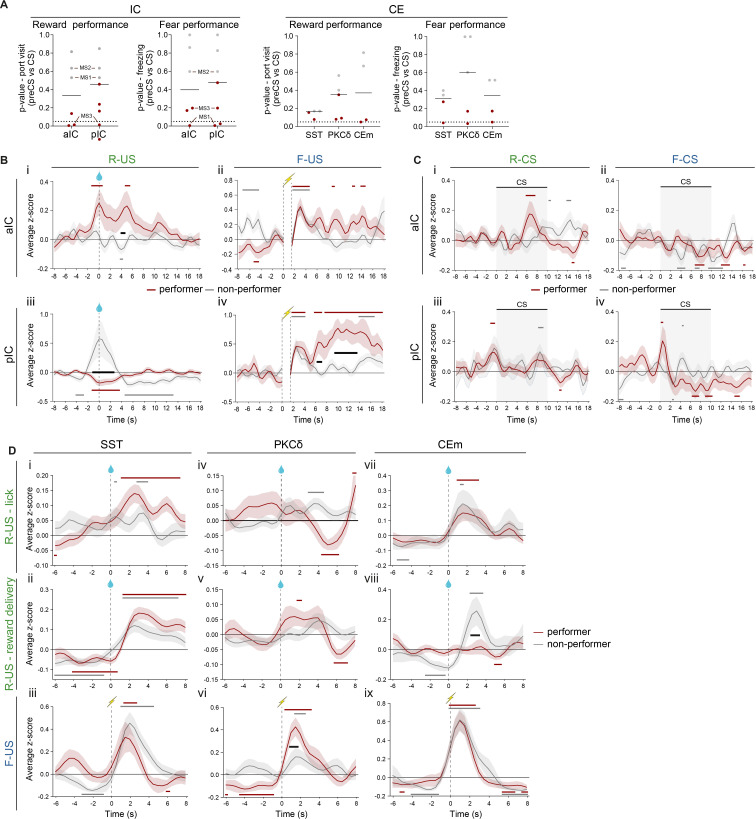
Performance-dependent responses to Pavlovian learning task stimuli in IC and CE.In all panels, black lines indicate significant differences (p<0.05) between subregions/populations, as determined by Holm-Sidak post hoc analyses, while colored lines indicate significant differences (p<0.05) from zero for each subregion/population, as determined by one-sample t-tests. All data presented as mean ± SEM. (A) Performance of individual mice in the reward (left) and fear (right) domain in IC and CE, as determined by the p-value from t-tests comparing the number of port visits (reward) and freezing episode onsets (fear) before and during CS presentations at recall. Color assignment of individual points according to a median split of p-values (red – performer, gray – non-performer). The median performer was assigned to the ‘performer’ group if its p-value was ≤0.5. (B) PETH of population responses according to performance for aIC upon (i) R-US (significant time x performance interaction in a two-way RM ANOVA, F52,7592=1.63, p=0.0029) and (ii) F-US (significant time x performance interaction in a two-way RM ANOVA, F50,3950=2.47, p<0.0001), and of pIC upon (iii) R-US (significant time x performance interaction in a two-way RM ANOVA, F52,6552=9.86, p<0.0001) and (iv) F-US (significant time x performance interaction in a two-way RM ANOVA, F50,3050=3.27, p<0.0001). (C) PETH of population responses according to performance for aIC upon (i) R-CS (significant time x performance interaction in a two-way RM ANOVA, F52,8268=2.09, p<0.0001) and (ii) F-CS (significant time x performance interaction in a two-way RM ANOVA, F52,8268=1.36, p=0.0434) and for pIC upon (iii) R-CS (no significant effect in a two-way RM ANOVA) and (iv) F-CS (significant time x performance interaction in a two-way RM ANOVA, F52,6188=1.81, p=0.0003). (D) (i-iii) PETH of population responses according to performance at recall for CESST upon R-US (top, significant time x performance interaction in a two-way RM ANOVA, F28,3052 = 2.33, p<0.0001; middle, significant effect of performance in a two-way RM ANOVA, F1,109=5.70, p=0.0187) and (bottom) F-US (significant time x performance interaction in a two-way RM ANOVA, F28,1344=2.22, p=0.0003). (iv-vi) PETH of population responses according to performance at recall for CEPKCδ upon R-US (top, significant time x performance interaction in a two-way RM ANOVA, F28,3192=3.07, p<0.0001; middle, significant time x performance interaction in a two-way RM ANOVA, F28,3220=1.56, p=0.0262) and (bottom) F-US (significant time x performance interaction in a two-way RM ANOVA, F28,1848=2.96, p<0.0001). (vii-ix) PETH of population responses according to performance at recall for CEm upon R-US (top, significant effect of time in a two-way RM ANOVA, F28,1512=3.95, p<0.0001; middle, significant time x performance interaction in a two-way RM ANOVA, F28,1512=2.92, p<0.0001) and (bottom) F-US (significant effect of time in a two-way RM ANOVA, F28,1204=22.73, p<0.0001). Full statistical report in Appendix 1—table 1.